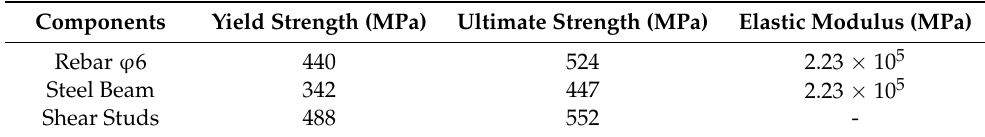
Table 1. Material properties of steel in NCB-4, NCB-5 and NCB-6.